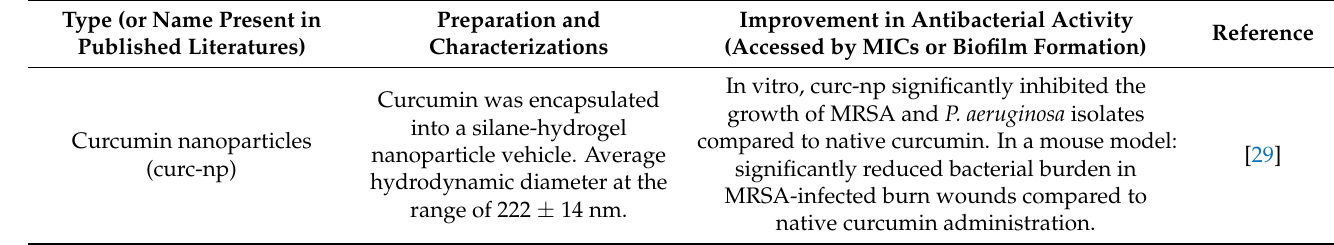
Table 3. Nano-formulations of curcumin and their antibacterial